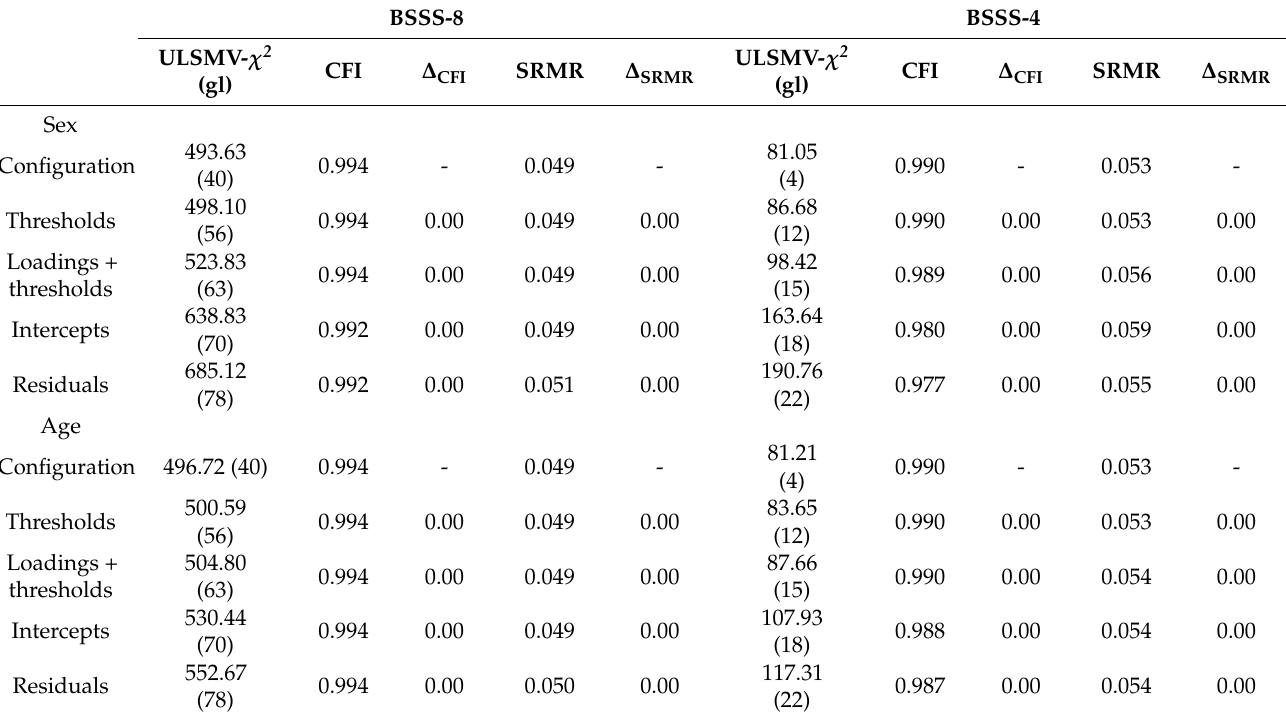
Table 4. Measurement invariance and correlation of the BSSS scores with sex and